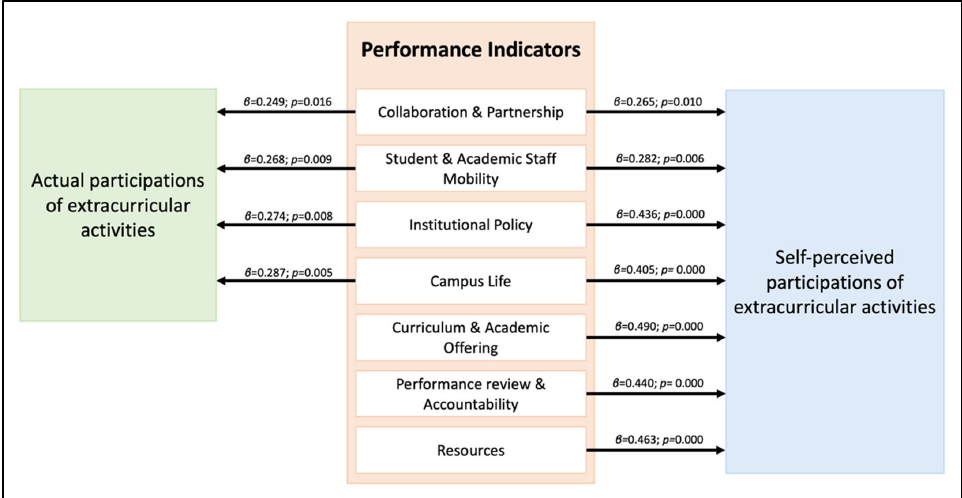
Figure 1. A statistical framework demonstrating the impact of internationalization on dental student life.